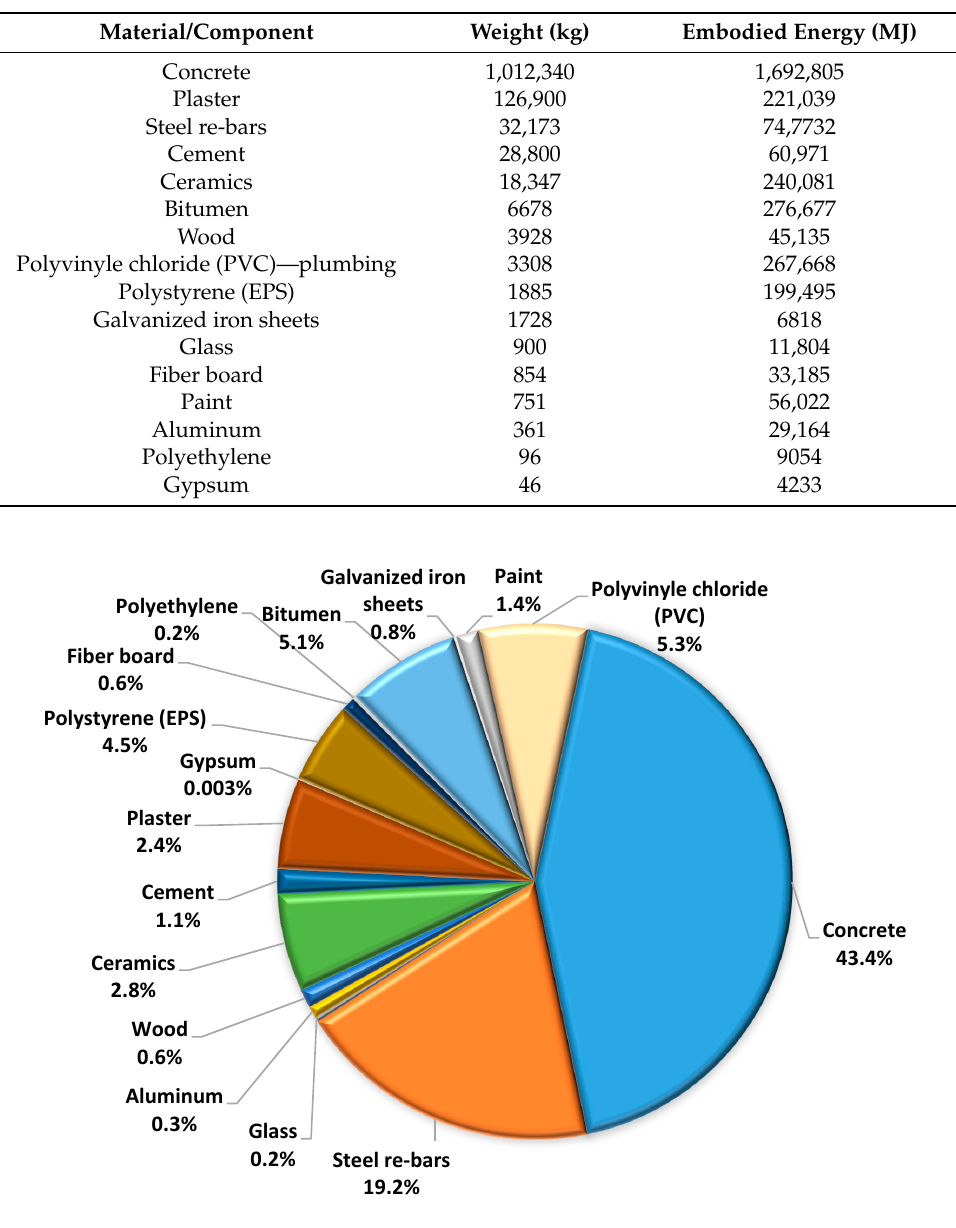
Figure 6. In terms of embodied energy per unit mass, however, concrete and plaster have least values while polystyrene is on the top of the list. Table 3. Embodied energy of materials involved in house construction.